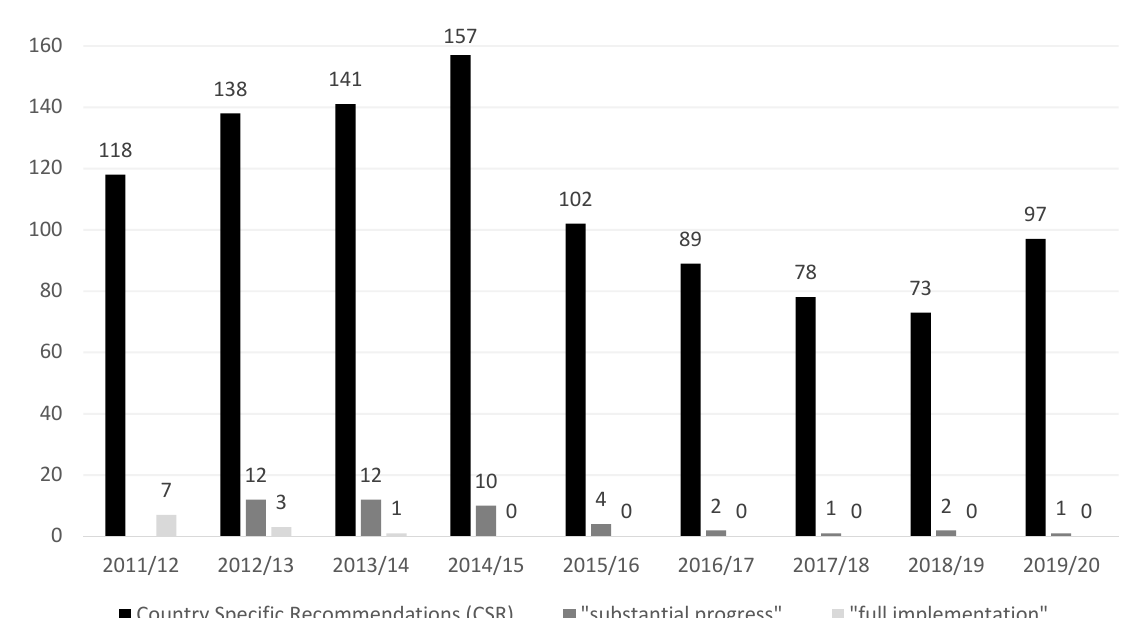
Figure 5. Responsiveness to reform proposals in the framework of the European Semester. Source: European Commission, König (2020).